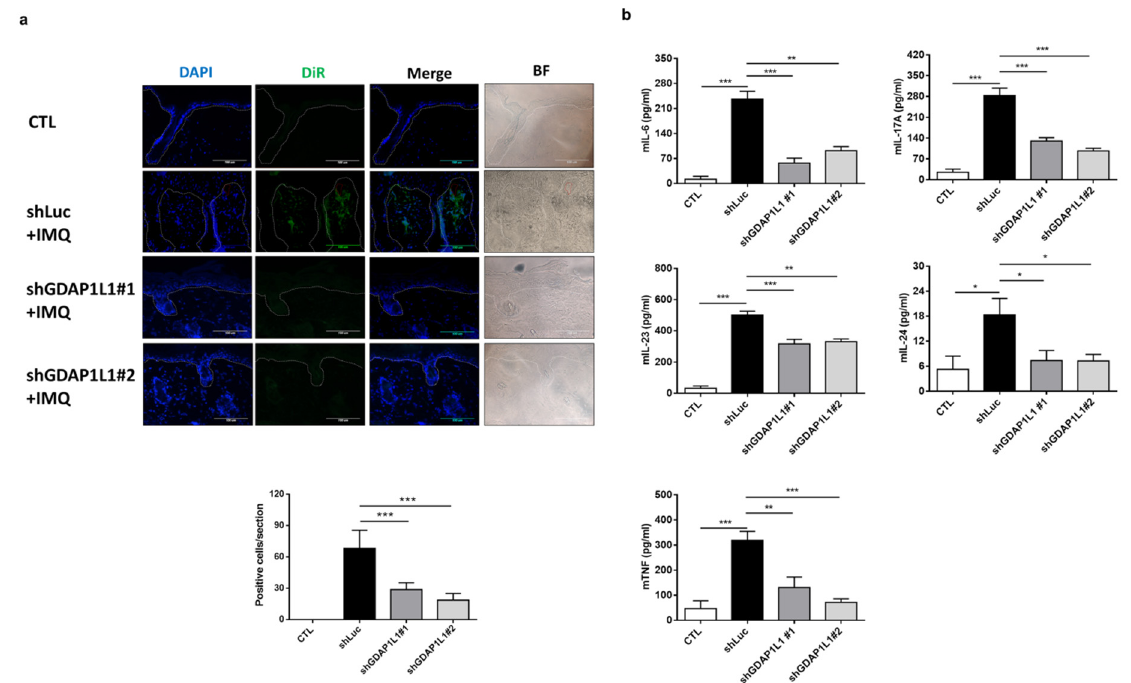
Figure 5. Loss of GDAP1L1 attenuated inflammation cytokine expression in an IMQ-induced mouse model. ( a ) Skin cryosections from the DiR-labeled control or GDAP1L1-deficient THP1 macrophage transplantation mice. DiR-labeled infiltrated macrophages (green) were found in the dermis and nearby thickened epidermis, as indicated by arrows. Cell nuclei (blue) were counterstained with DAPI. The dotted lines indicate the border between the epidermis and dermis. Scale bar, 100 µ m. Quantitative analyses of DiR-labeled infiltrated macrophages in the skin were counted in high-power fields. ( n = 5) is presented in the bottom panel. ( b ) Production of cytokines as indicated in the skin ( n = 5 − 6) was measured with ELISA. * p < 0.05, ** p < 0.01 and *** p < 0.001 when compared to control group. Data are represented as mean ± SEM of three independent experiments.